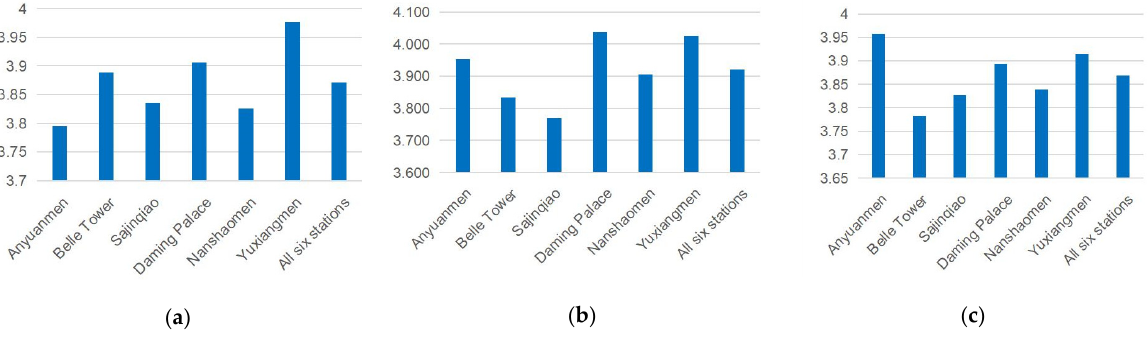
Figure 6. Evaluation results for environmental design, cultural image perception and place perception. ( a ) Environmental design, ( b ) Cultural image perception, ( c ) Place perception.